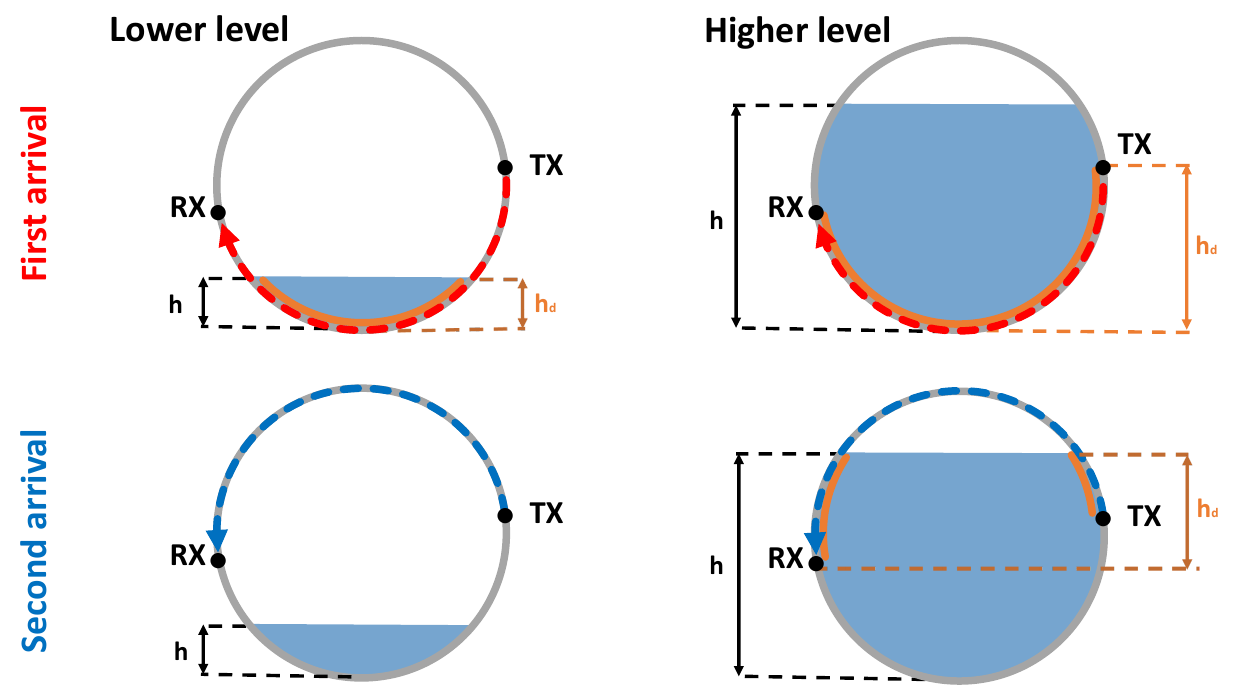
Figure 1. Exemplary first arrival travel path (FA, red) and second arrival travel path (SA, blue), for two different filling heights below ( left row ) and above ( right row ) the participated sender (TX) and sensor (RX). For each combination the travel path length with occurring energy conversion caused by the filling is marked orange. The resulting height section covered by the data is h d whereby the exact filling height is given by h